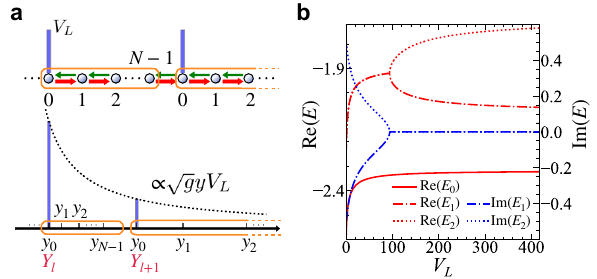
Fig. 2 Changing boundary conditions. a A constant potential, V L , is added to the fi rst site in each unit cell of the superlattice. The corresponding potential in the curved space depends on the position. b Eigenenergies for the ground state E 0 2 R and the fi rst two excited states E 1 ; 2 2 C as functions of V L